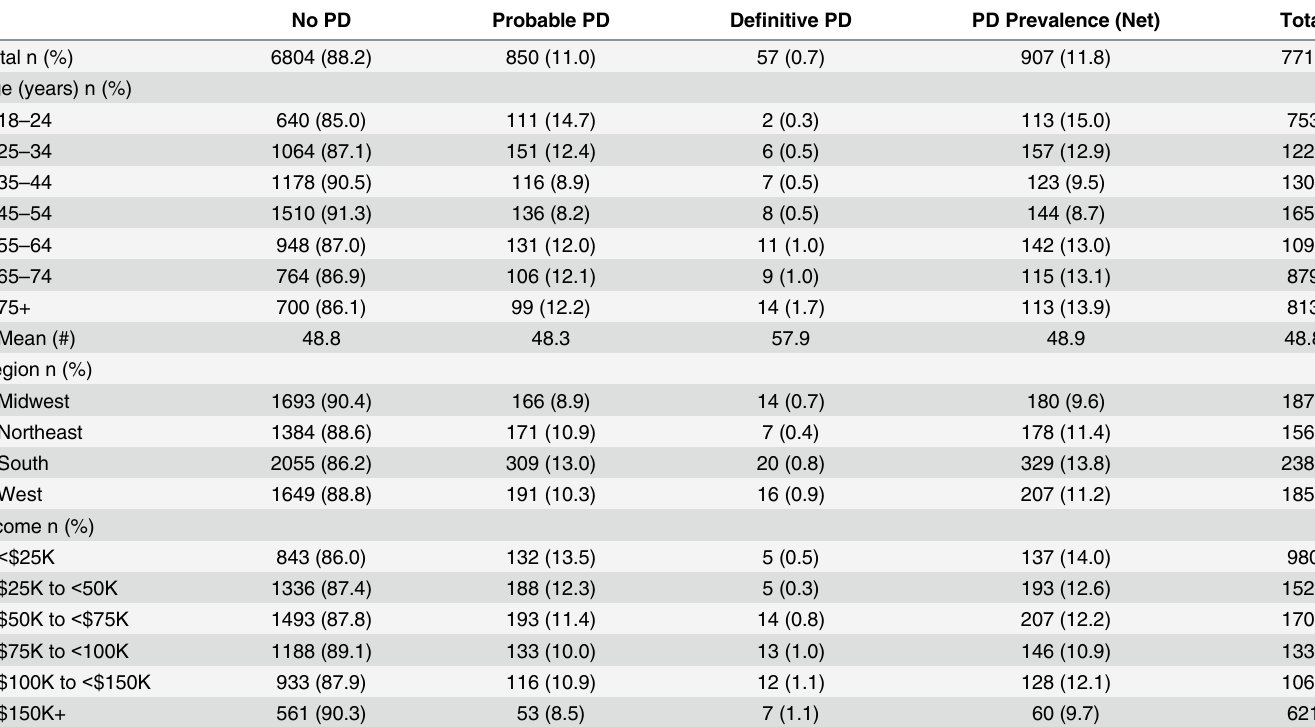
Table 2. PD prevalence by demographic